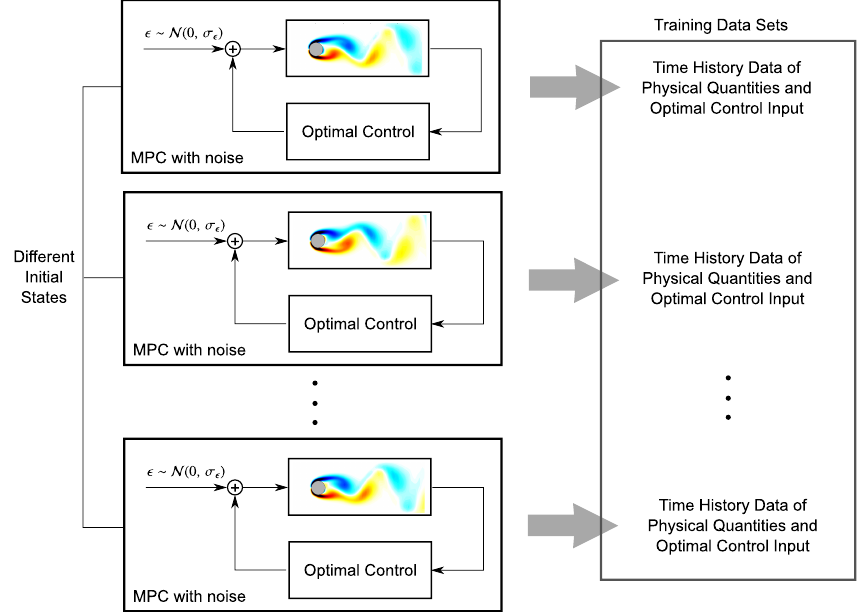
Figure 8. The method to produce training data